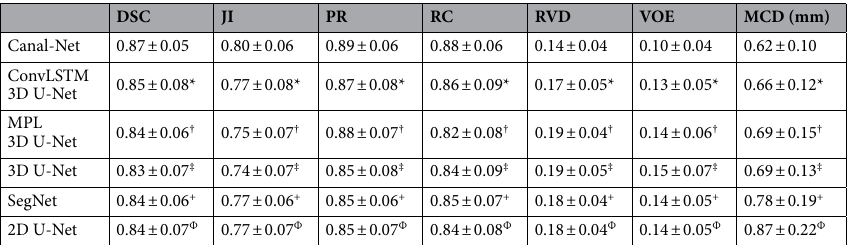
Table 2. Mean (SD) dice similarity coefficient score (DSC), Jaccard index (JI), precision (PR), recall (RC), volume of error (VOE), relative volume difference (RVD), and mean curve distance (MCD) by Canal-Net (ours), ConvLSTM 3D U-Net (ours), MPL 3D U-Net (ours), 3D U-Net, SegNet, and 2D U-Net Net by five-fold cross-validation. *Significant difference between Canal-Net and ConvLSTM 3D U-Net (p < 0.05). † Between Canal-Net and MPL 3D U-Net (p < 0.05). ‡ Between Canal-Net and 3D U-Net (p < 0.05). + Between Canal-Net and SegNet (p < 0.05). Φ Between Canal-Net and 2D U-Net (p < 0.05).